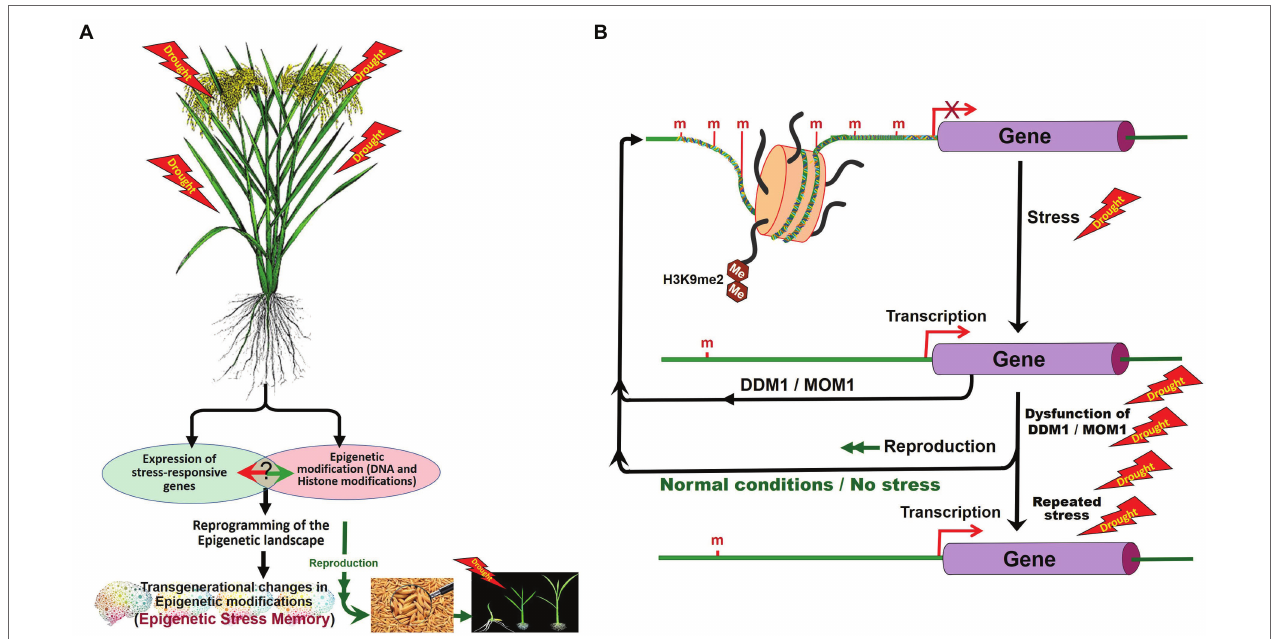
FIGURE 5 | Role of DNA methylation in stress tolerance and epigenetic stress memory in plants. Abiotic stresses may alter the expression of the stress-responsive genes and cause DNA base modifications. In stressed plants, epigenetic modifications reprogram the epigenetic landscape and some of the epigenetic changes may be inherited (A) . Expression of stress-responsive genes may also cause changes in epigenetic modifications. After the stress, during the recovery period, Morpheus Molecule 1 (MOM1) and DDM1 erase the stress-induced epigenetic marks. Inheritance of stress-induced epigenetic marks/de-silencing of genes can be seen in plants repeatedly exposed to the tress due to the dysfunction of DDM1 and MOM1 (B) . H3K9me2, dimethylated histone H3 lysine 9 (Modified from Zhang et al.,